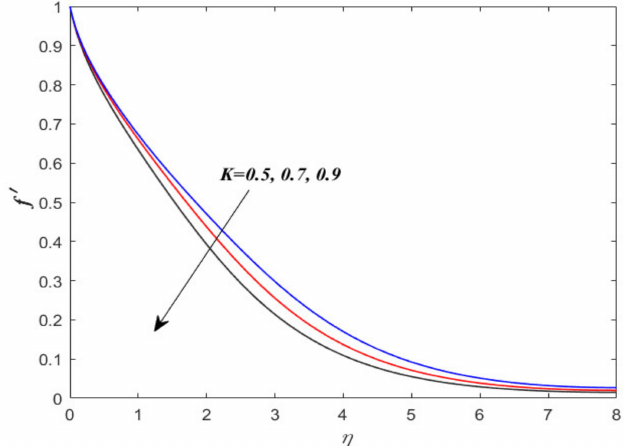
Figure 2. Various values of magnetic parameter ( M ) on velocity f (cid:48) ( η ) .